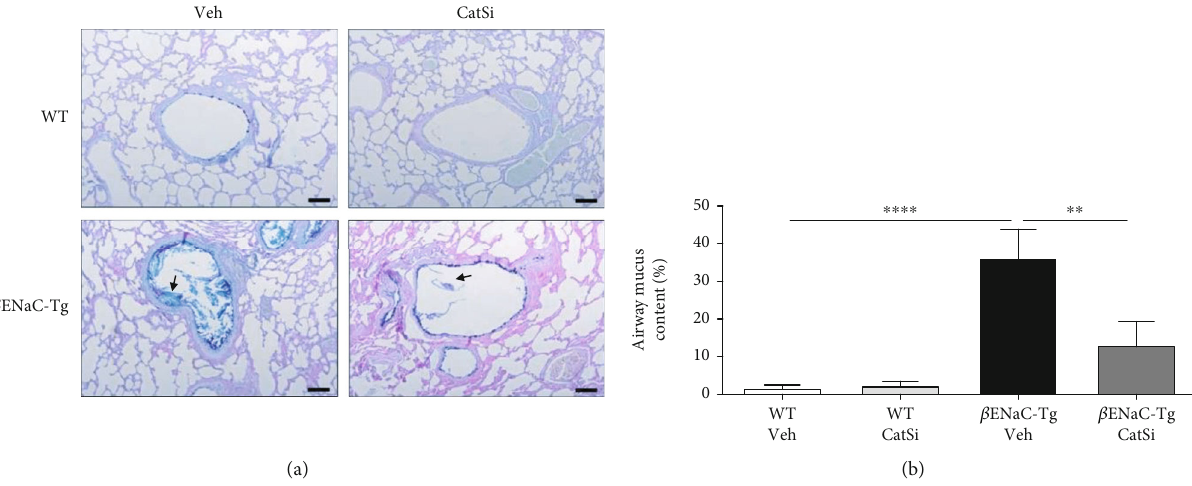
Figure 6: Pharmacological targeting of cathepsin S reduces airway mucus plugging. Four-week-old WT and β ENaC-Tg mice were treated daily with cathepsin S inhibitor VBY-999 (CatSi, 100mg/kg) or dextrose vehicle control (veh) for 14 days. (a) Representative images of adult WT and β ENaC-Tg mice lung sections stained with Alcian blue-periodic acid Schi ff . Black arrows indicate airway mucus, scalebar = 100 μ m . (b) Airway mucus quanti fi cation is expressed as the percentage of the total airway area containing mucus ( n = 8 ‐ 9 per group). ∗∗ P < 0 : 01 , ∗∗∗∗ P < 0 : 0001 (one-way ANOVA with Tukey ’ s multiple comparisons test).